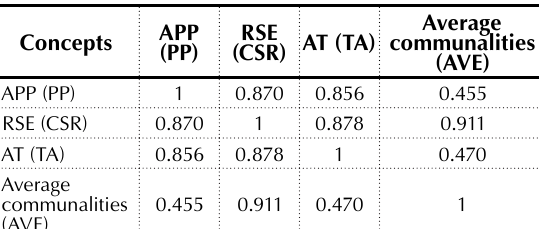
Table 6. Discriminant validity